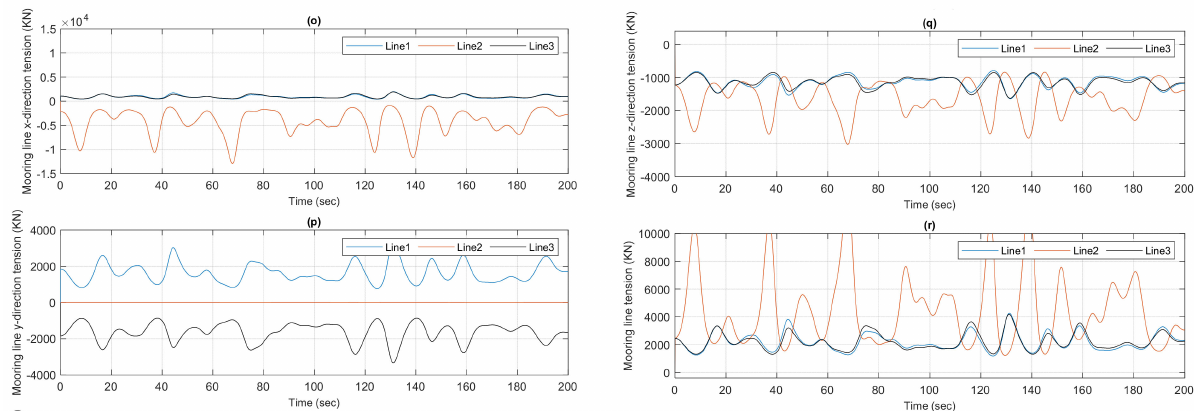
Figure 15. Simulation results under 50-year return-period extreme conditions, with wind speed 57 m/s and 3% turbulence: ( a ) wind speed, ( b ) wave height, ( c ) rotor speed, ( d ) roto- speed error, ( e ) output power, ( f ) generator torque, ( g ) blade-pitch, ( h ) tip-speed ratio, ( i ) floater surge, ( j ) floater sway, ( k ) floater heave, ( l ) floater roll, ( m ) floater pitch, ( n ) floater yaw, ( o ) mooring-line x-direction tension, ( p ) mooring- line y-direction tension, ( q ) mooring-line z-direction tension, ( r ) mooring-line